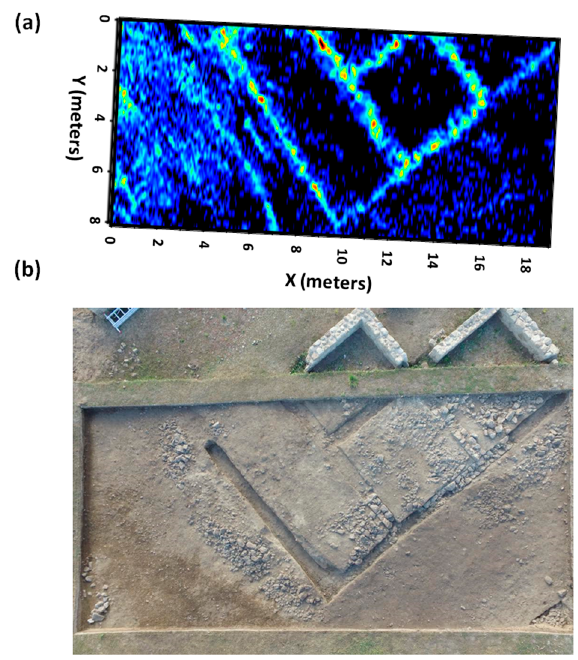
Figure 7. Results of grid 1 in the Southern sector of the camp: ( a ) 3D overlaid image and interpretation, and ( b ) aerial picture of a recent excavation.